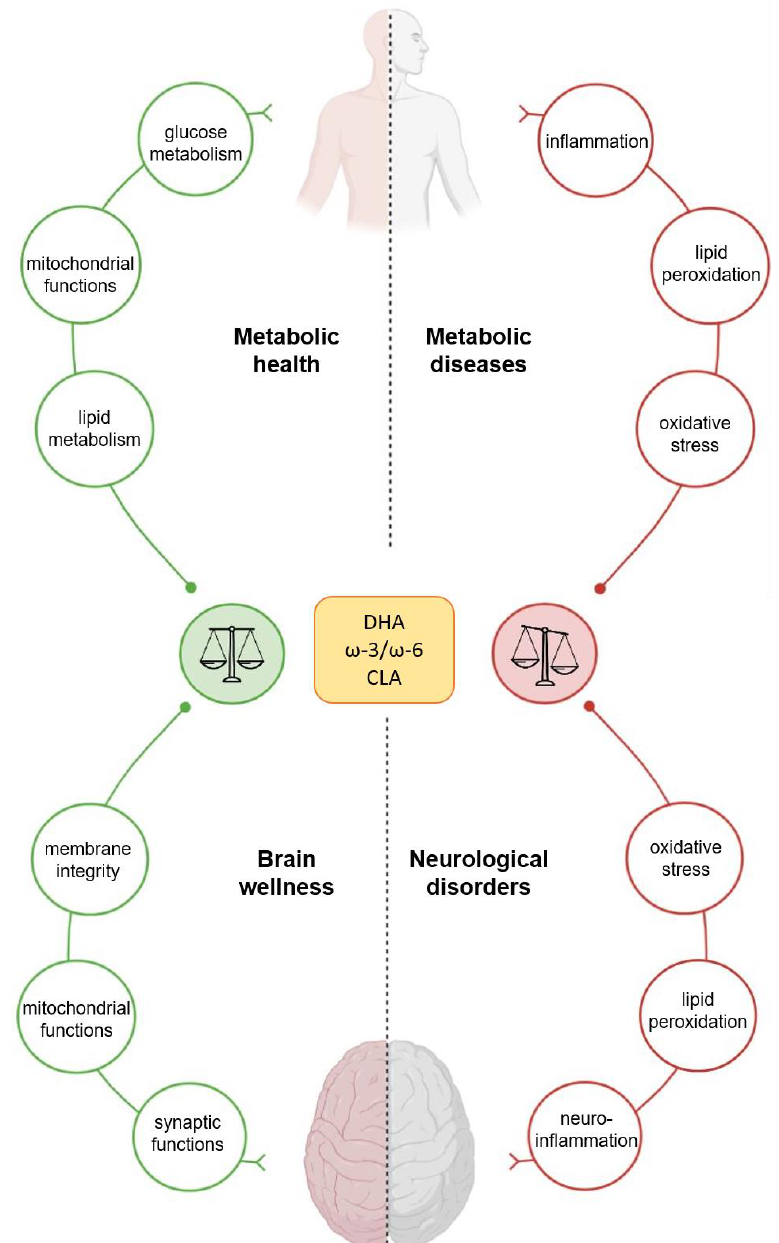
Figure 1. Effects of docosahexaenoic acid (DHA), conjugated linoleic acid (CLA), and ω-3/ω-6 on human wellness. The nutritional supply of DHA, CLA, and ω-3–ω-6 PUFAs has a great impact on human health, affecting the metabolism of peripheral organs and the brain’s functions.